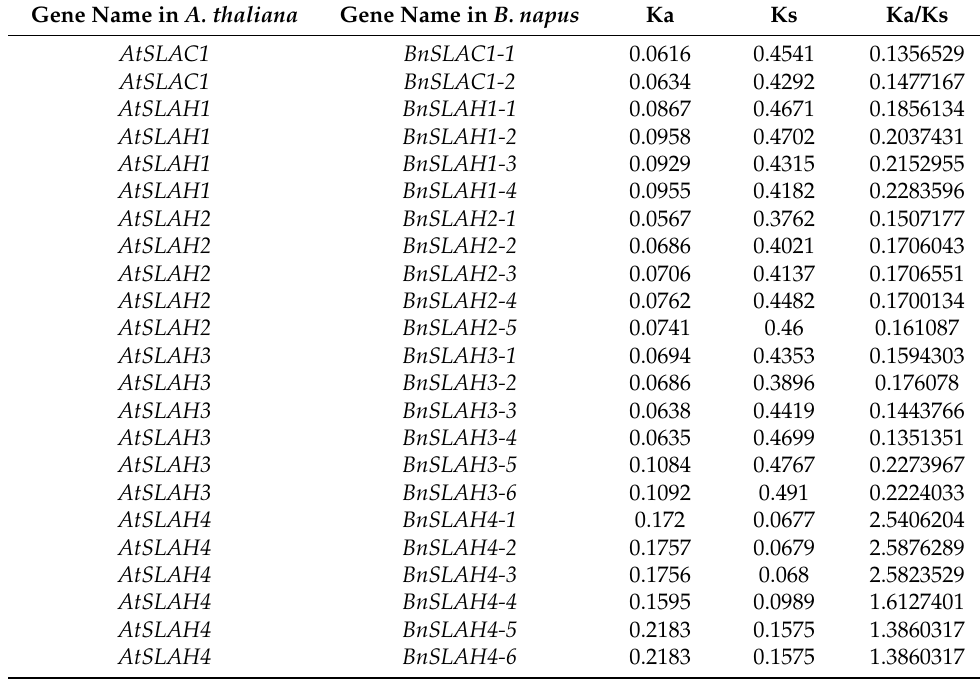
Figure 1. Phylogenetic tree of SLAC/SLAHs among B. napus , B. rapa , B. oleracea , A. thaliana and O. sativa . The tree was generated using MEGA 6.0 with the Neighbor-Joining method. The proteins clustered into three subgroups. Yellow, blue and green sections indicate the three subfamilies of the SLAC/SLAH proteins. B. napus SLAC/SLAHs were marked with red dot. Table 2. The synonymous substitution rates (Ks) and non-synonymous substitution rates (Ka) of the SLAC/SLAHs in A. thaliana and B. napus